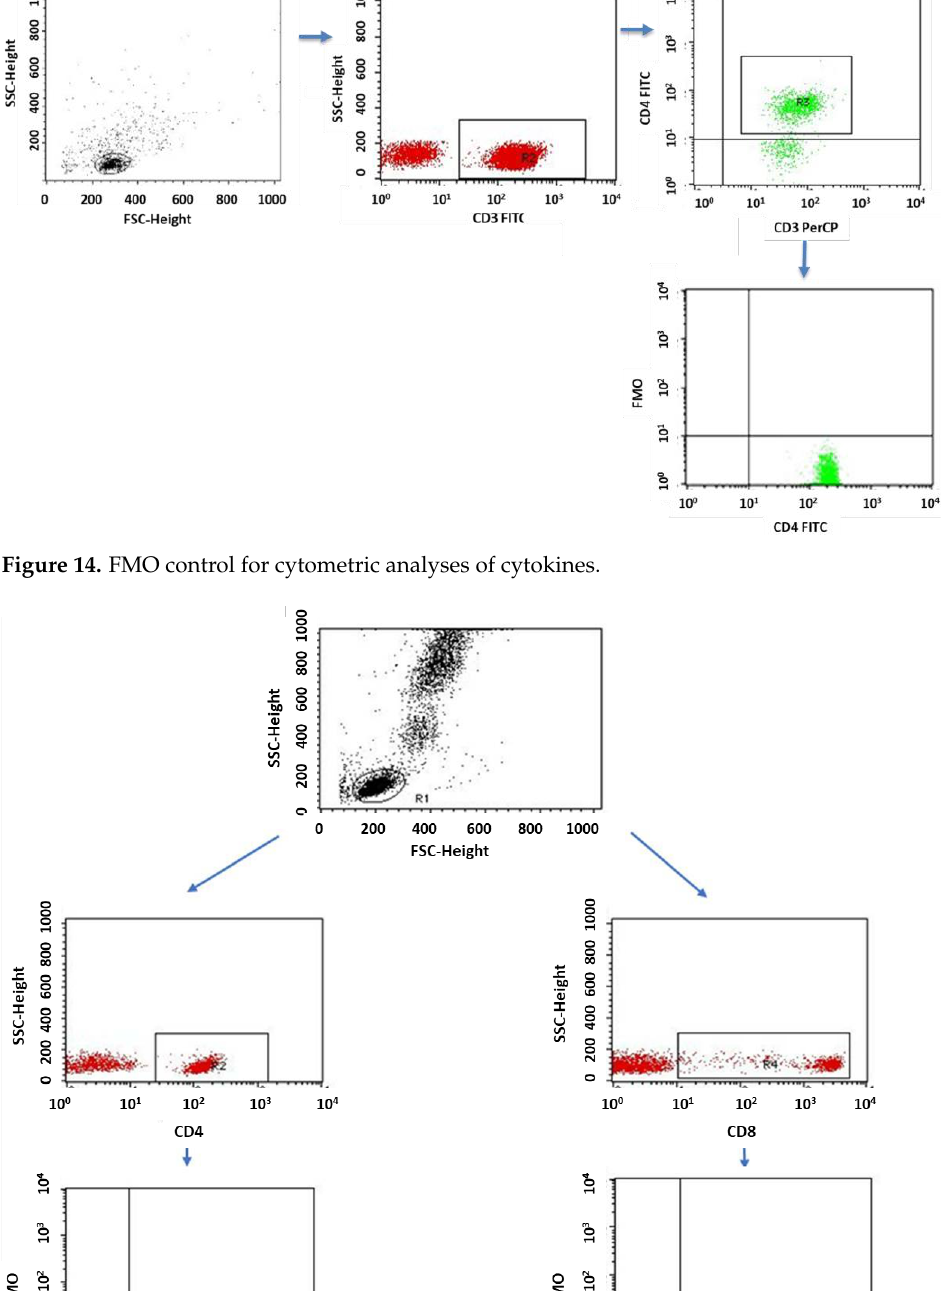
Figure 15. FMO control for cytometric analyses of CD69+ and CD25+ cells.